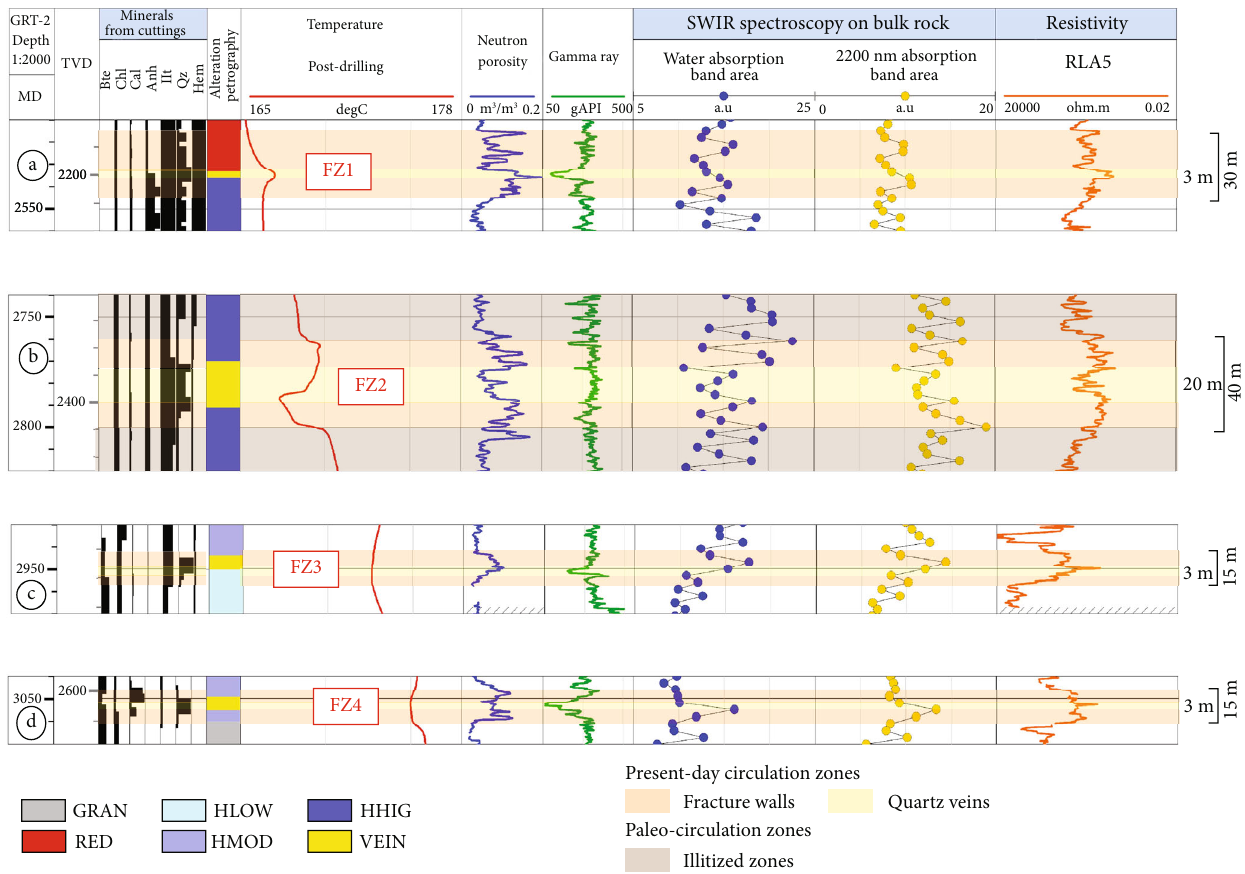
Figure 6: Magni fi ed view of the four (a, b, c, and d) main permeable FZs of the GRT-2 well at Rittersho ff en, presenting the mineral quantity, petrographical log, T log, porosity and density logs, total GR, SWIR results with water and the 2200nm absorption band areas, and resistivity log (low values to the right). Petrographical facies abbreviations are de fi ned in the legend in Figure